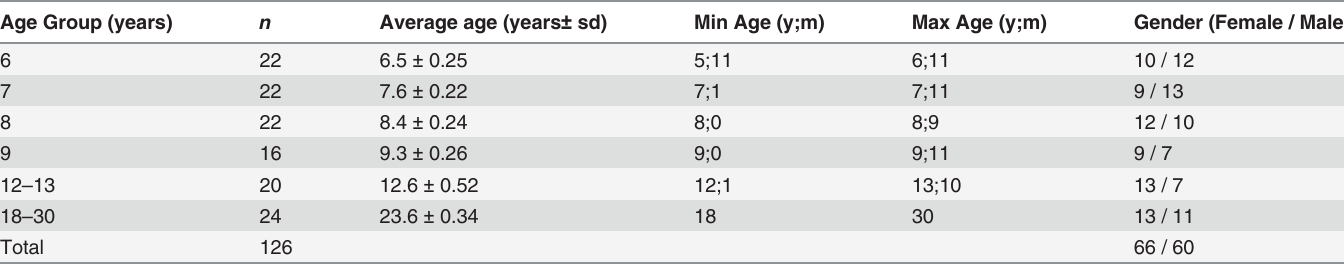
Table 1. Description of the participants.